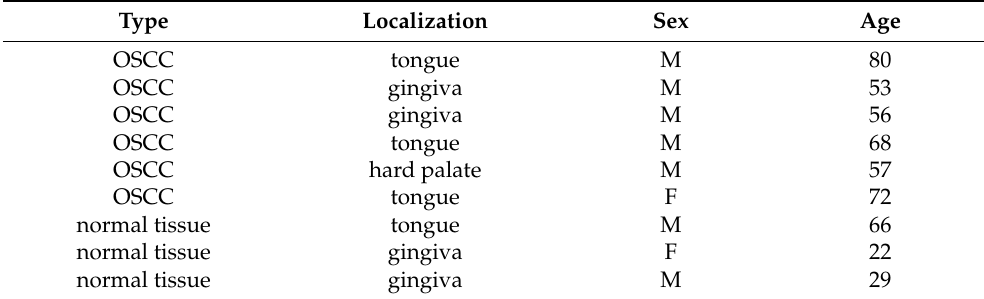
Table 2. Summary of the occurrence and demographics of the patients with histologically vali- dated squamous cell carcinoma and control samples for RNAscope in situ hybridization (M = male, F =